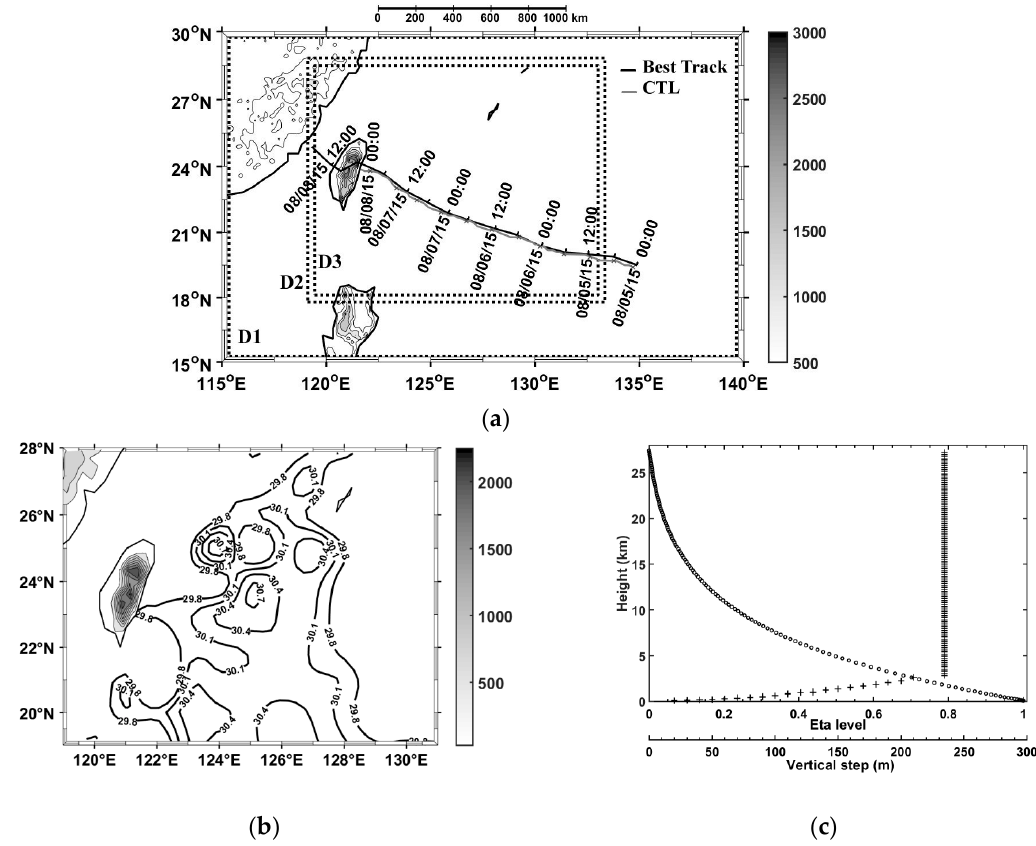
Figure 1. ( a ) Best track of Typhoon Soudelor (black) from 5 August 00:00 UTC to 8 August 18:00 UTC in 6 h intervals, and the WRF (Weather Research and Forecasting) TC track (gray) from CTL from 5 August 00:00 UTC to 8 August 00:00 UTC in 1 h intervals. Dotted rectangles visualize parent and nested domains D1, D2 and D3 of the simulation. Shaded contours (every 500 m derived from 2 arc min gridded global relief data Etopo2) and the colorbar (m) display the Central Mountain Range heights. ( b ) Initial SST field (°C) on 5 August 00:00 UTC and terrain elevation (m) with 30 s resolution used for CTL. ( c ) Vertical distribution of 130 eta levels (circle) and corresponding vertical step height (plus) up to 27 km in the lower stratosphere (LS).